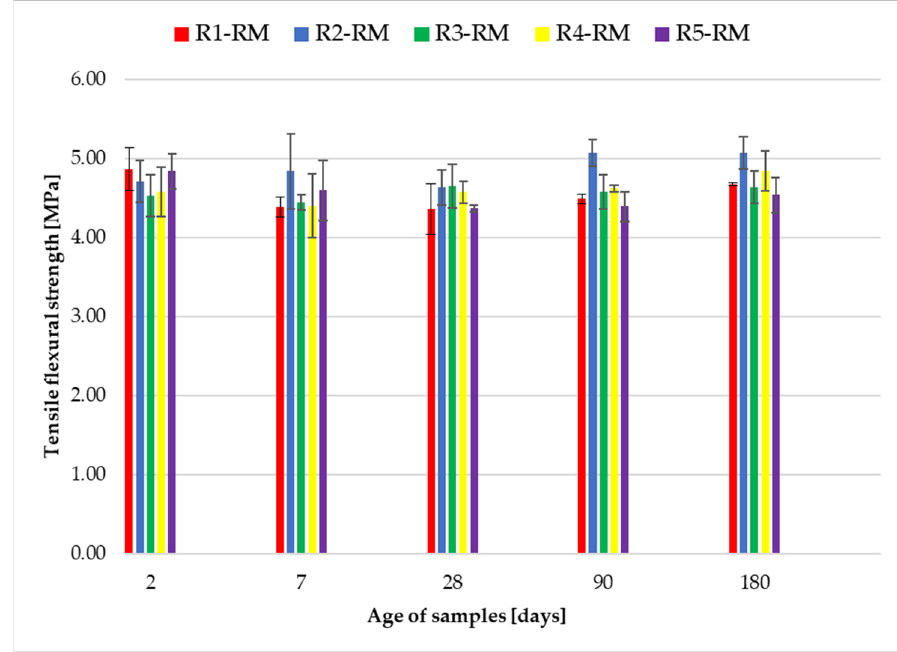
Figure 9. Graphic expression of flexural strengths after 2, 7, 28, 90 and 180 days.